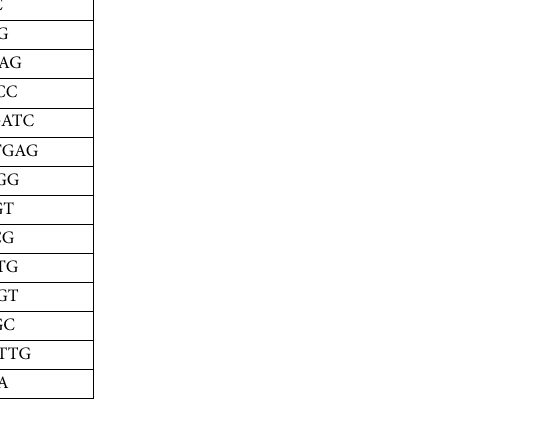
Table 1. RT-PCR primers used in the